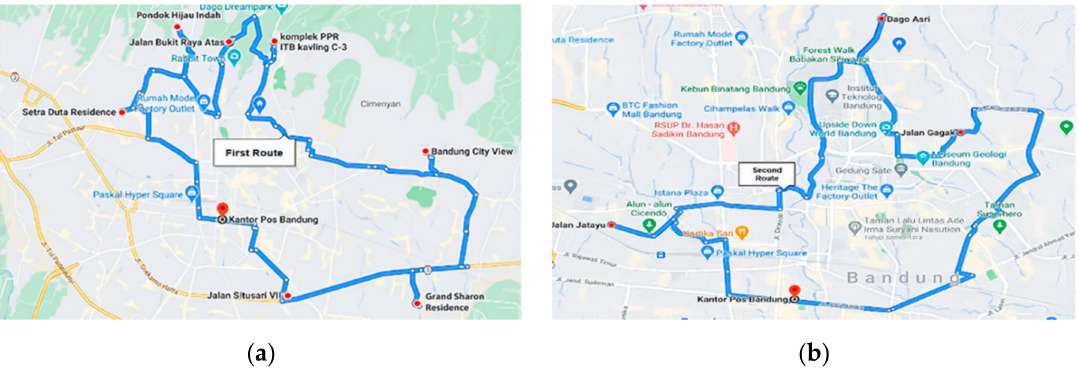
Figure 9. The route is chosen for ( a ) the first route and ( b ) the second route using Google